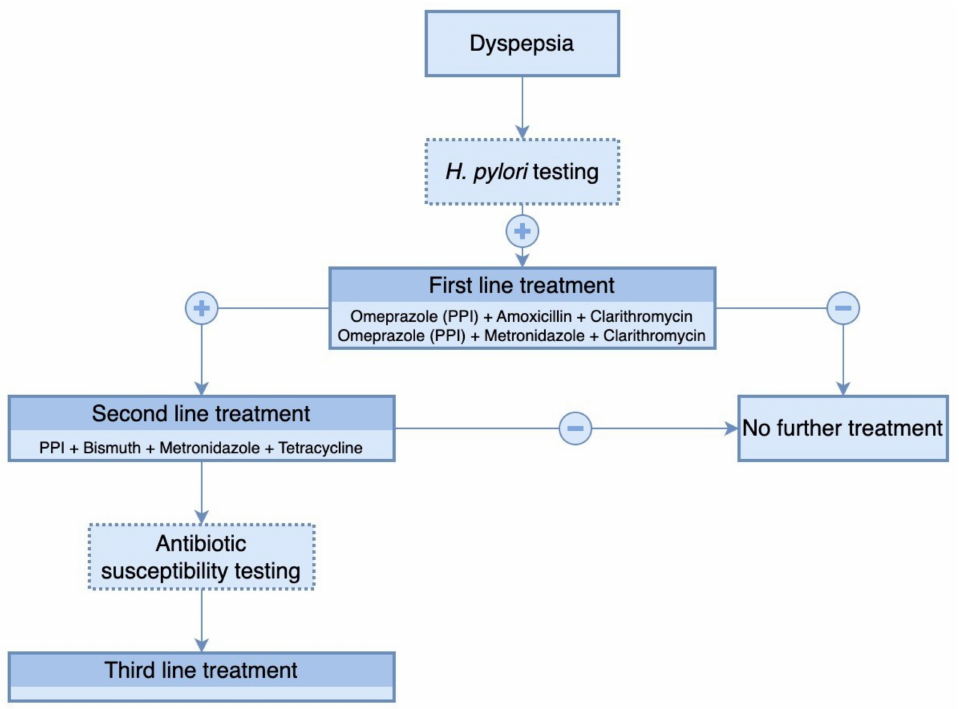
Figure 3. Therapeutic algorithm for eradication of H. pylori